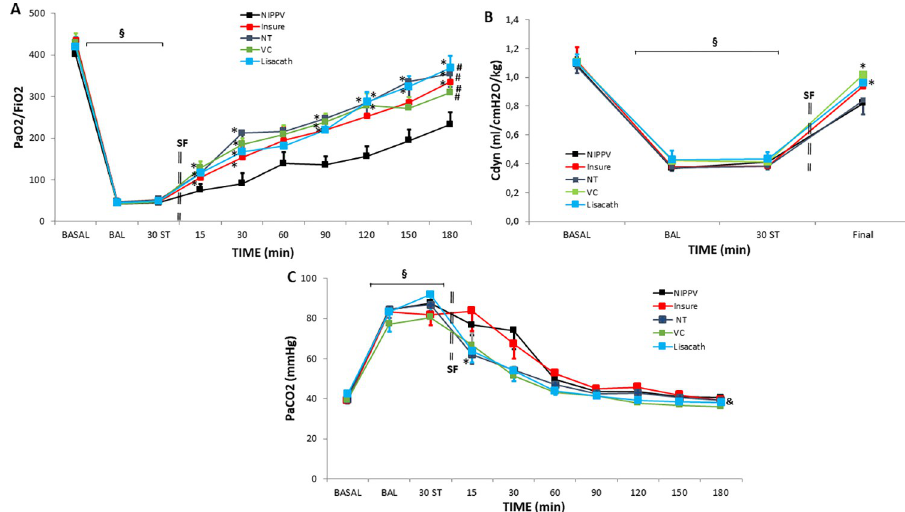
Fig 2. P aO2 /F iO2 ratio, dynamic compliance (Cdyn) and P aCO2 in newborn piglets with broncoalveolar lavage- induced respiratory distress treated with nasal-intermittent-positive-pressure-ventilation (NIPPV) without SF therapy or with SF therapy, using the INSURE-like method, LISA with a nasogastric tube (NT), LISA with a vascular catheter (VC) or LISA with the LISAcath 1 catheter over the 180-min treatment period. Values of P aO2 / F iO2 (A), Cdyn (B), and P aCO2 (C) in the NIPPV alone (black), INSURE (red), NT (dark-blue), VC (green) and LISAcath (blue) groups. The Cdyn value at 180 min was measured after the reintubation of the animals at the end of the study. (§)p < 0.05 vs baseline; ( * )p < 0.05 vs NIPPV group (one-way-ANOVA); (#)p < 0.05 vs NIPPV group and (&) p < 0.05 vs INSURE group (two-way-ANOVA). Values = mean ± SEM. ST: stabilization.